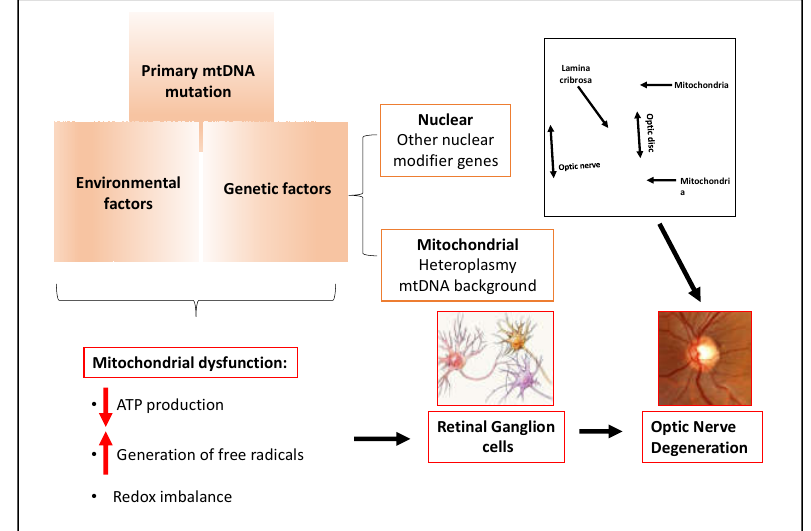
Figure 4. Mitochondrial dysfunction in glaucoma.